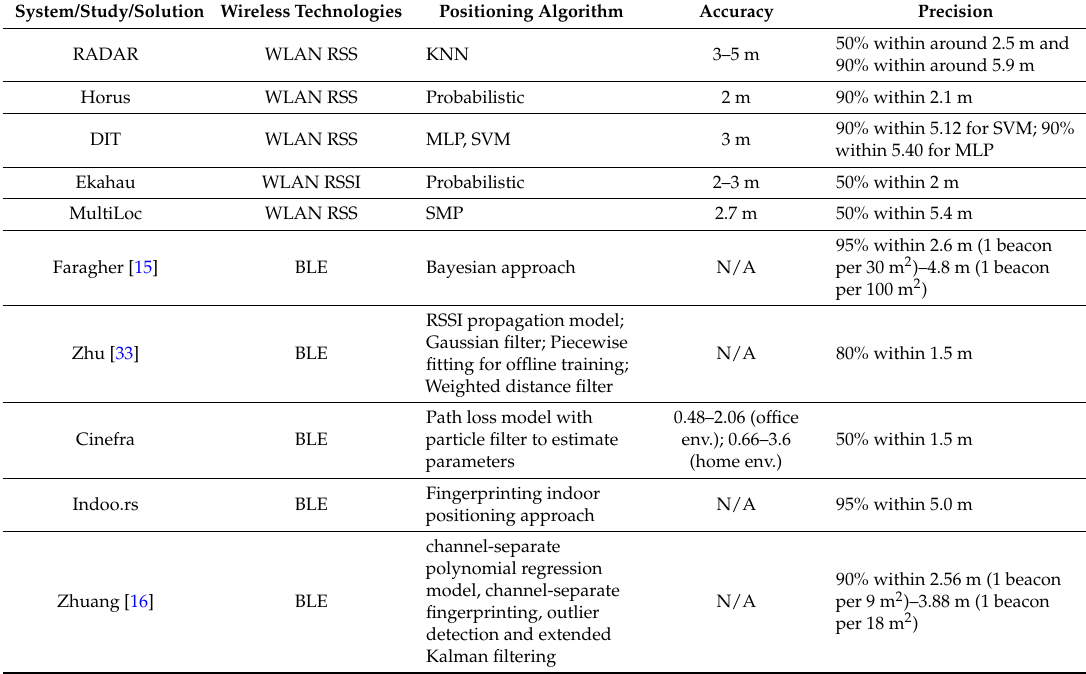
Table 10. Some wireless-based indoor positioning systems, studies and solutions [5,35,36]. System/Study/Solution Wireless Technologies Positioning Algorithm Accuracy